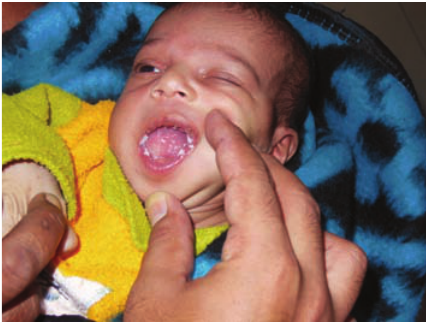
Figure 1: Clinical photograph of the patient with congenital ranula.